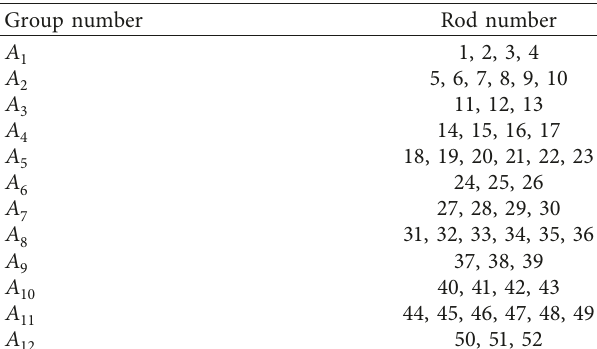
Figure 9: Schematic diagram of the 52bar plane truss structure. Table 7: 52bar plane truss structure